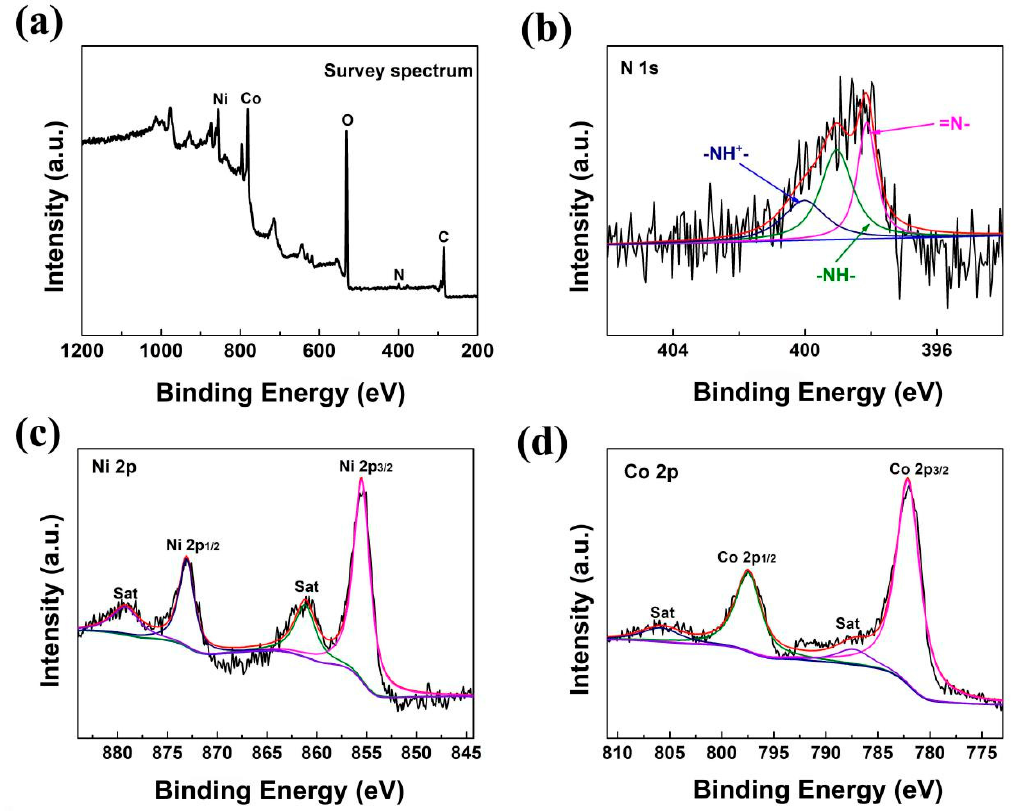
Figure 4. ( a ) XPS survey scan spectrum of PANI/LDH-200; ( b ) high-resolution N1s, ( c )Ni 2p and ( d ) Co 2p spectra of PANI/LDH-200.